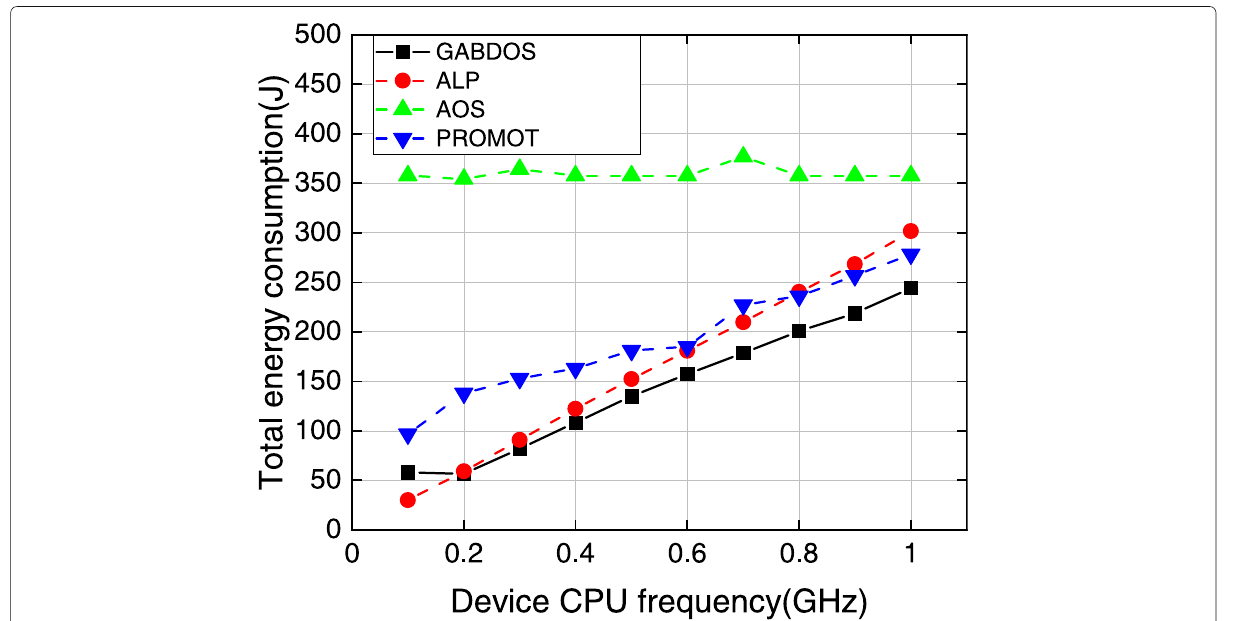
Fig. 9 Impact of user device CPU frequency on total energy consumption